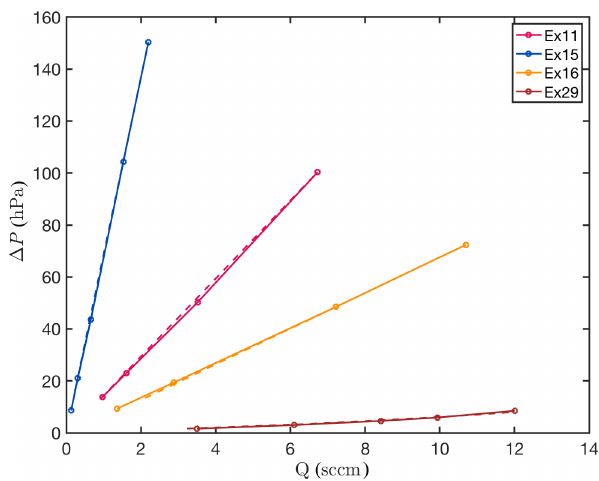
Figure C1. The linear relations between applied pressure differ- ence and flow rate show that Darcy’s law is valid and no turbulent flow occurs. Solid lines represent measurements while increasing the pressure difference, and dashed lines represent decreasing the pressure difference (sccm: standard cubic centimetres per